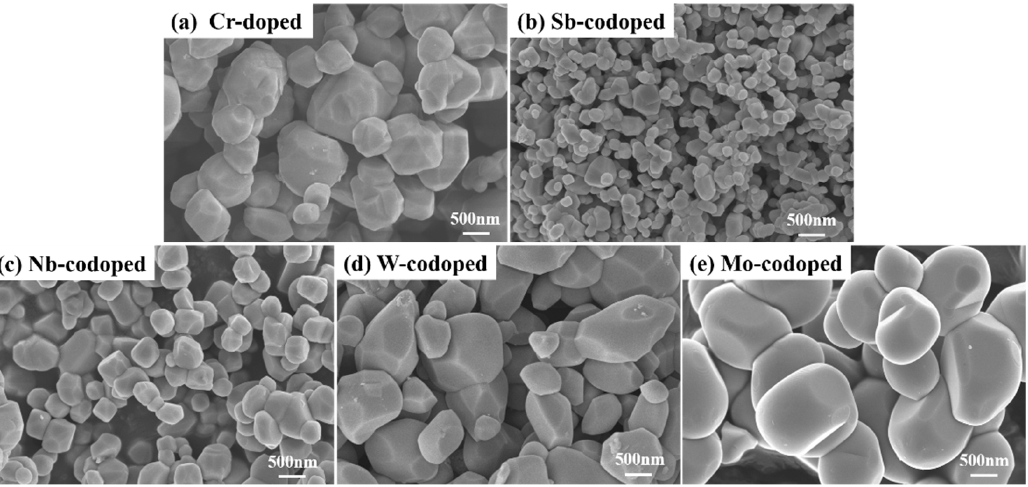
Figure 6. SEM images of the Cr-doped TiO 2 pigments without ( a ) and with counterions: ( b ) Sb, ( c ) Nb, ( d ) W and ( e ) Mo. The synthesized Ti 0.9 Cr 0.1 O 2 and Ti 0.8 Cr 0.1 M 0.1 O 2 (M = Sb, Nb, W, and Mo)